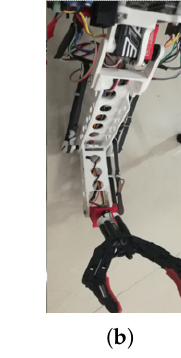
Figure 1. The proposed aerial manipulator system. ( a ) modules; ( b ) 4-DoF manipulator with a